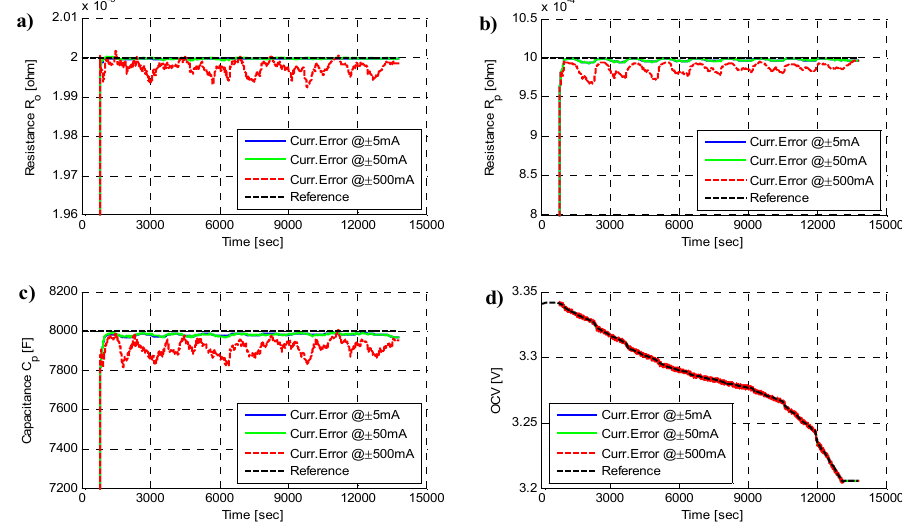
Figure 8. Estimated model parameters: ( a ) R o , ( b ) R p , ( c ) C p , and ( d ) OCV at the current precisions of ±5/±50/±500